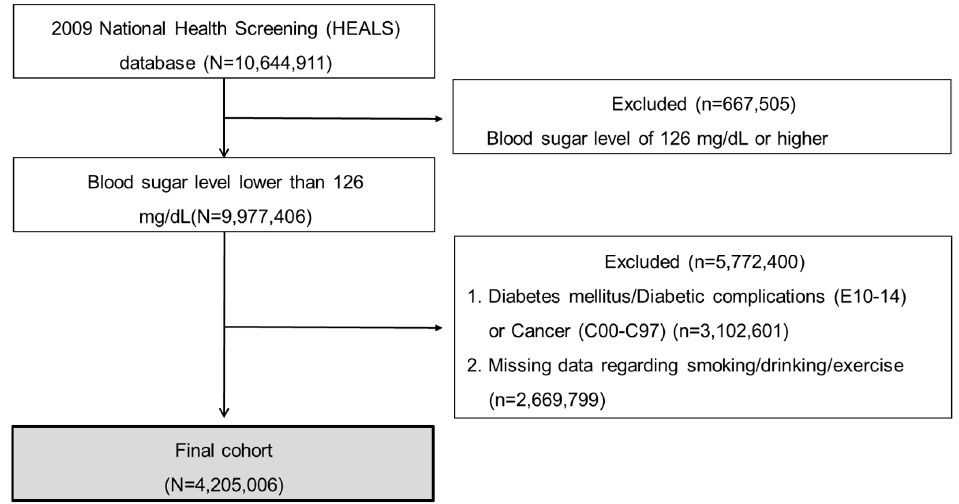
Figure 2. Selection of the study subjects.